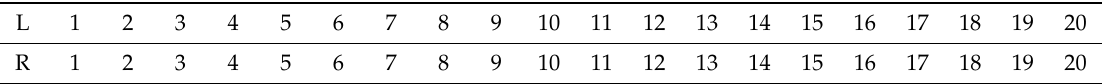
Figure 1. Vulnerable points of a quay crane: ( a ) left vulnerable points; ( b ) right vulnerable points.